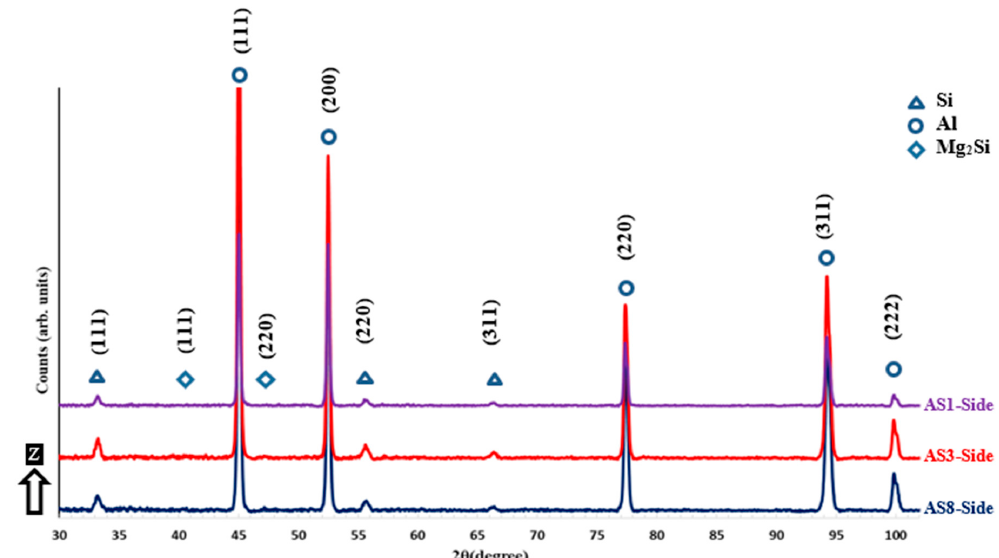
Figure 4. XRD phase pattern measured on the side surface (along the Z-direction) of different as-built AlSi10Mg samples.